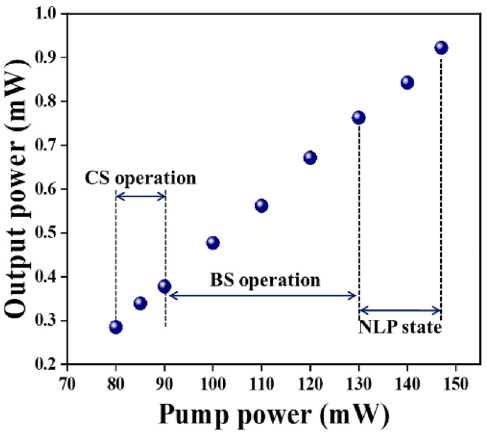
Figure 7: The relationship between pump power and output power at different mode-locked